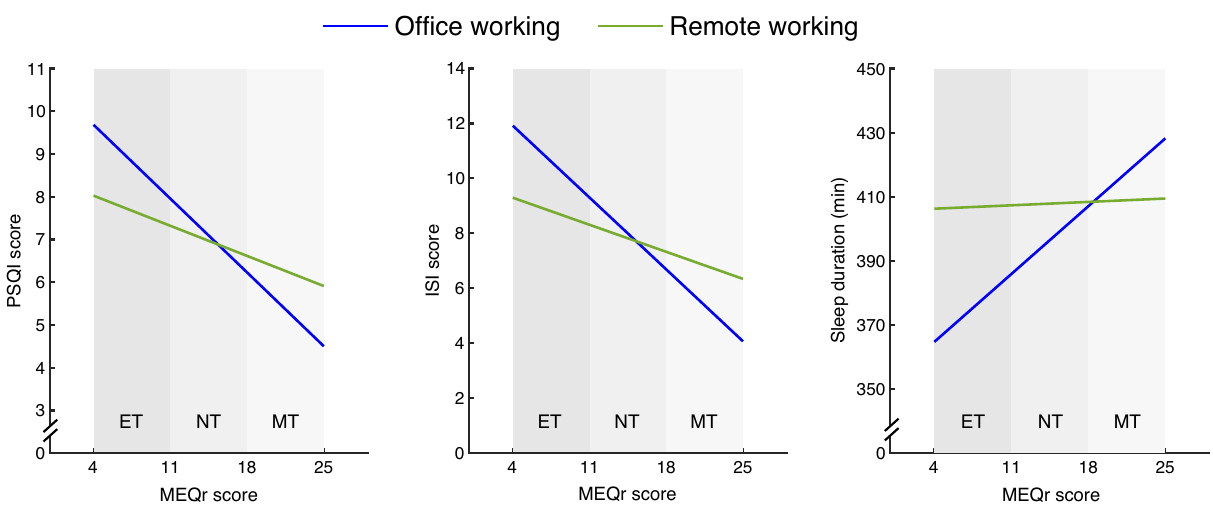
Figure 2. Simple slope analyses of the interaction between MEQr scores and working modality [office working (blue line), remote working (green line)] on sleep quality (PSQI score), insomnia symptoms (ISI score), and sleep duration (min). Gray bands discriminate chronotypes according to the validated cut-off scores. Abbreviations: ET, evening type; NT, neither type; MT, morning type; PSQI, Pittsburgh Sleep Quality Index; ISI, Insomnia Severity Index; MEQr, Morningness-Eveningness Questionnaire-reduced